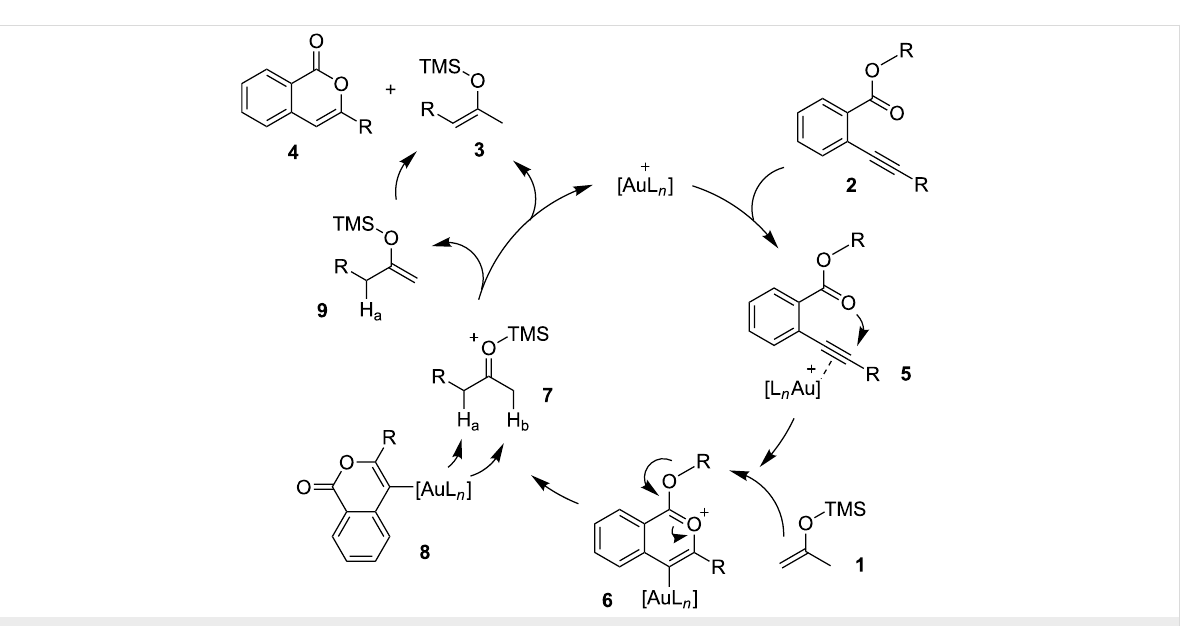
Scheme 2: Plausible mechanism for the alkylation of silyl enol